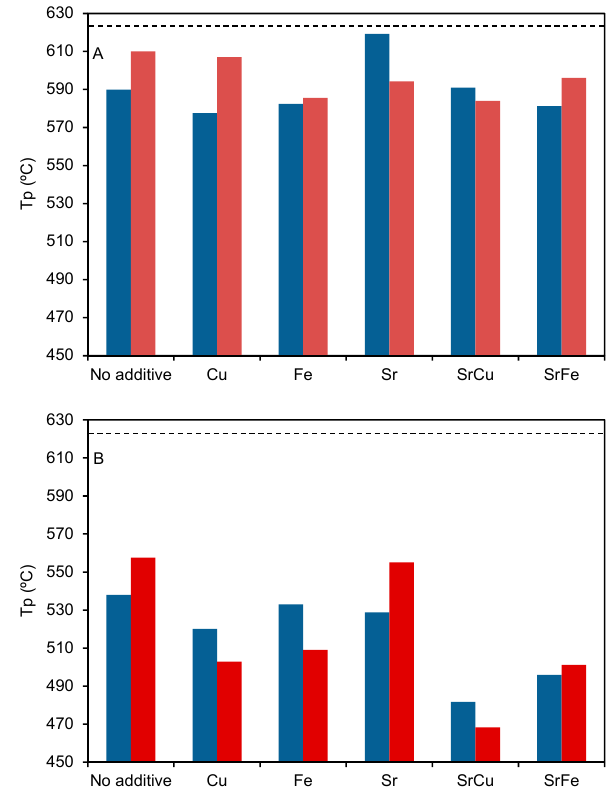
Figure 3. Catalytic activity as T p (°C) for soot combustion under loose contact conditions in ( A ) O 2 /N 2 and ( B ) NO/O 2 /N 2 atmosphere for CeO 2 ( blue )- and ZrO 2 ( red )-based catalysts. The broken line indicates the soot oxidation temperature for uncatalyzed reactions.